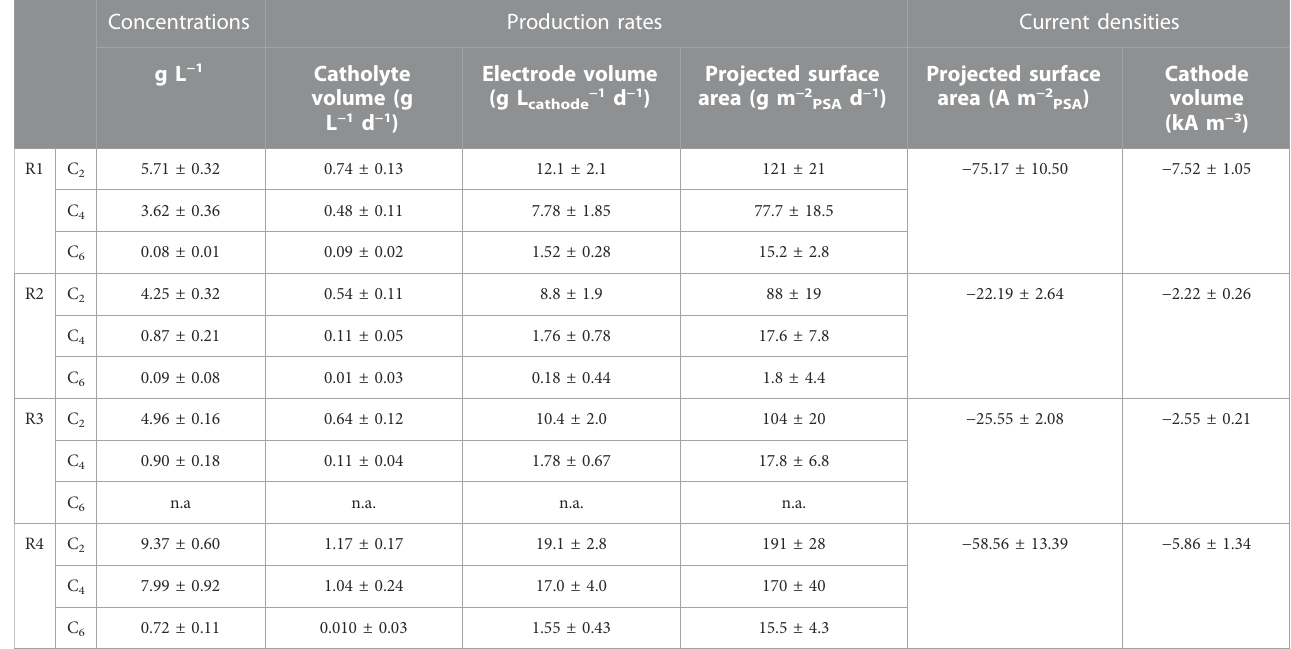
TABLE 1 Conventional key performance indicators in MES: concentration, production rates and current densities. Selected time periods for R1: days 71 – 101, for R2: days 75 – 118, for R3 days 54 – 92, and for R4 days 141 – 198. Reactors were operated for 194 days with a HRT of 8 days. C 2 , C 4 and C 6 refer to acetate, butyrate, and hexanoate respectively. PSA: projected surface